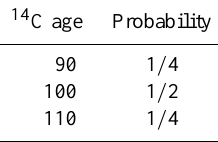
Table 1. Sample’s